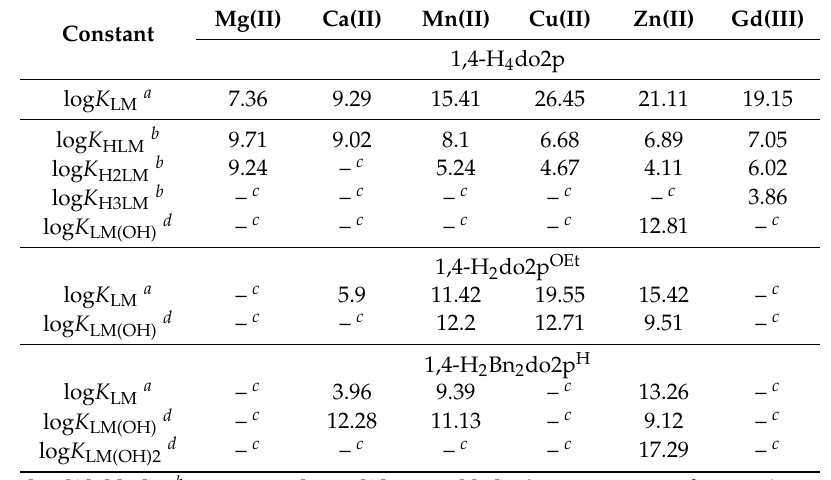
Table 2. Stability and protonation constants of 1,4-H 4 do2p, 1,4-H 2 do2p OEt , and 1,4-H 2 Bn 2 do2p H complexes with selected metal ions (25 ◦ C, I = 0.1 M NMe 4